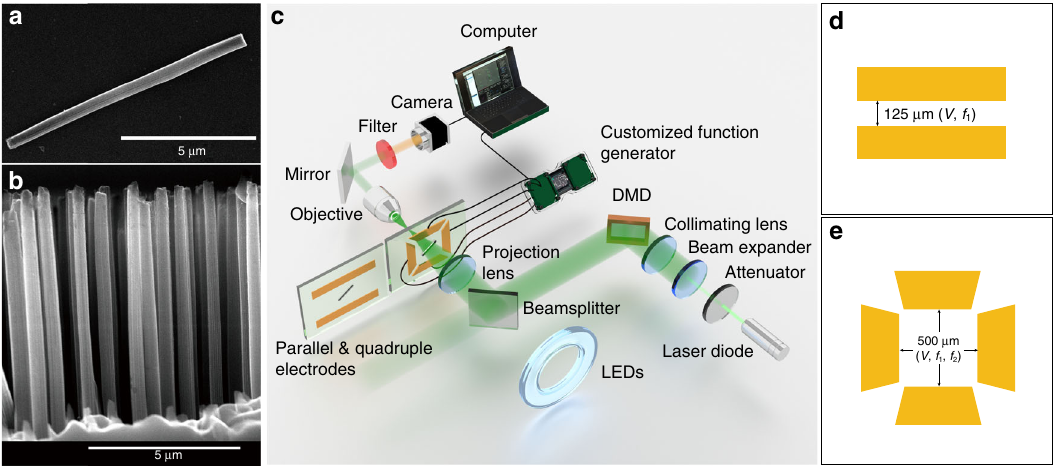
Fig. 1 a , b SEM images of the fabricated undoped silicon nanowires with 10- μ m length and 500-nm diameter. a A single silicon nanowire. b Cross-section image of silicon nanowire arrays. c Schematic of experimental setup for switchable alignment of nanowires and rotation of micro stepper motors (relative position of each component is shown; the microelectrodes faces upward in the actual setup); ( d ) parallel microelectrodes for electro-alignment measurement; ( e ) and quadruple microelectrodes for actuation of the stepper